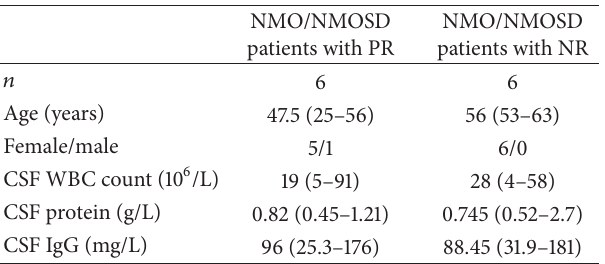
Table3:Thedemographicandclinicalfeaturesof12NMO/NMOSD patients after